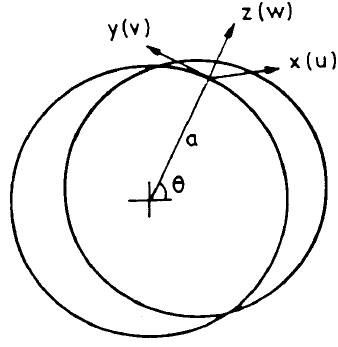
Fig. 1. Pictorial representation of the co-ordinate system used.